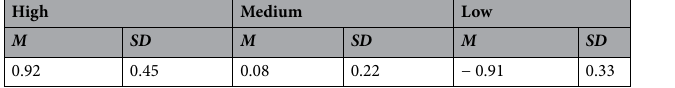
Table 1. Mean z -scores and SD of the composite scores of STAI-Trait and IAF for each